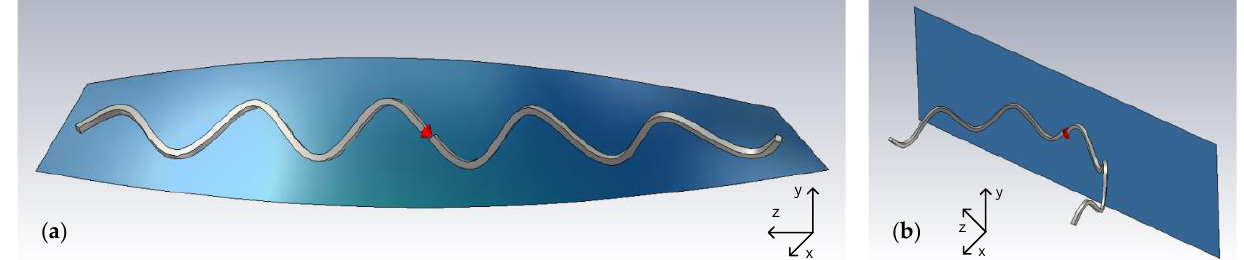
Figure 14. Illustration of ( a ) the twisting and ( b ) the bending applied to the modeled antenna in simulation software. The blue metallic-colored plane, the thick wire, and the lighting effects are added for a better presentation of the 3D